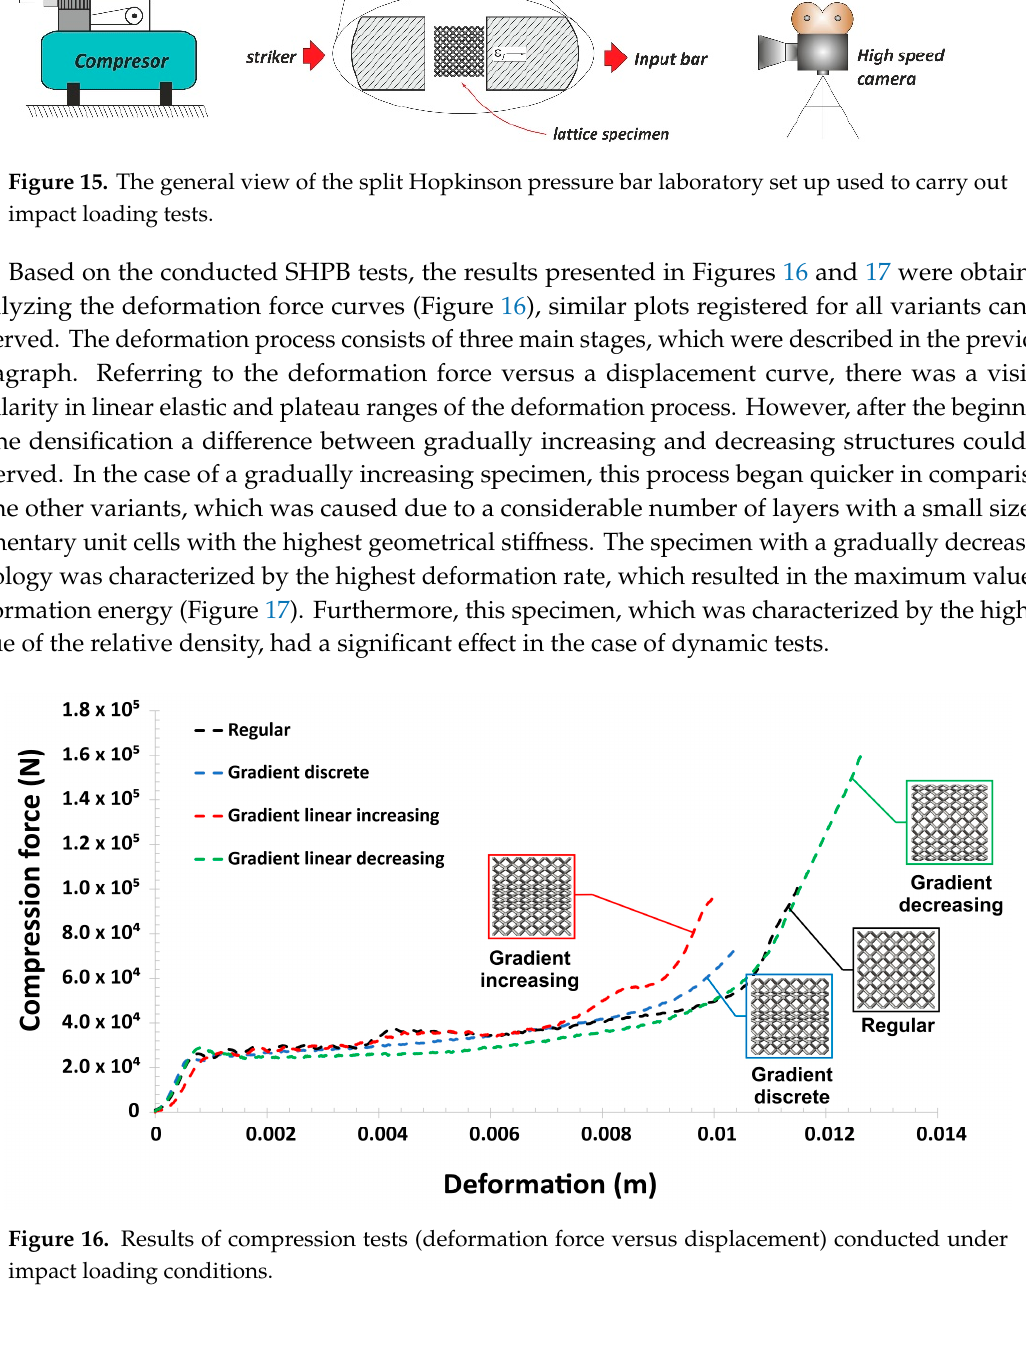
Figure 17. Results of compression tests (deformation energy versus displacement) conducted under impact loading conditions. 4. Discussion Figure 18 presents the comparison of deformation of all lattice structures (regular and gradient ones) after both static and impact compression tests. These results show an evident difference in the global deformation of gradient structures. The regular structure deformed in a typical linear uniform way—the sidewalls of these structures are parallel to each other. The structure with a discrete gradient demonstrated deformation almost the same to the above-mentioned, whereas the gradient lattice structures behaved differently. For a regular structure, linear deformation happens if all unit cells of lattice structure are symmetrical (or slightly asymmetrical). In the structure with an increasing gradient, when loaded under the compression, the lateral deformation was outward in the top part,